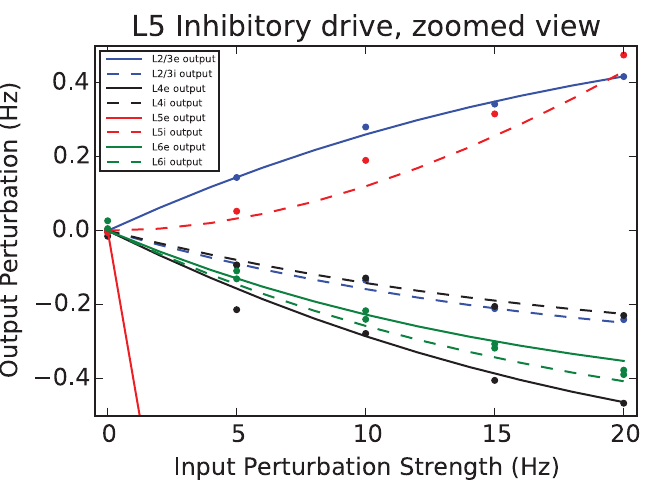
Fig 7. Nonlinearity resulting from drive into L5 inhibitory population. This expanded view of row 3, right column of Fig 5 demonstrates the strongly inhomogeneous response resulting from driving the L5 inhibitory population. Solid and dashed lines indicate perturbations of excitatory and inhibitory populations, respectively (L2/3, blue; L4, black; L5, red; L6, green). Simulations in NEST (100 averaged leaky integrate-and-fire simulations) are plotted as points.